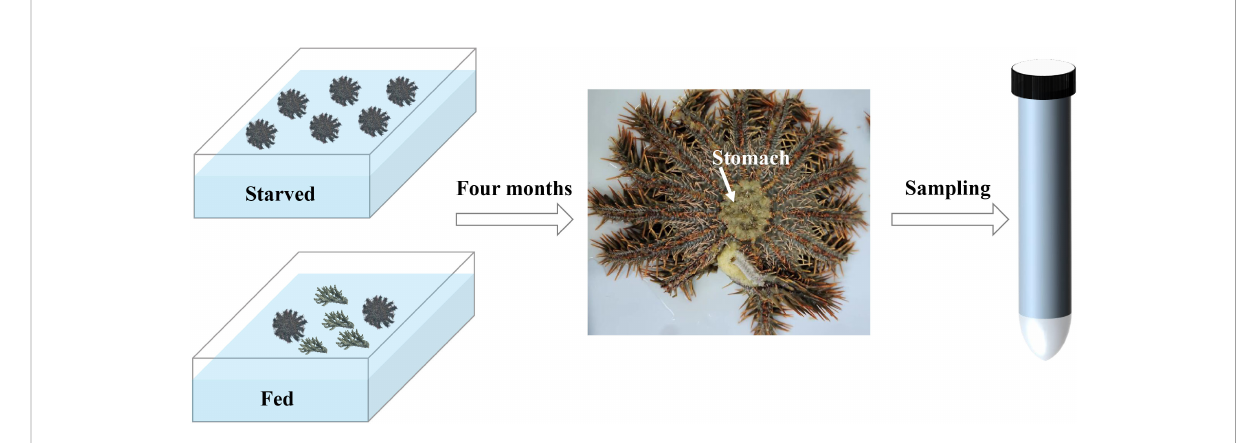
FIGURE 1 CoTS starvation experiment